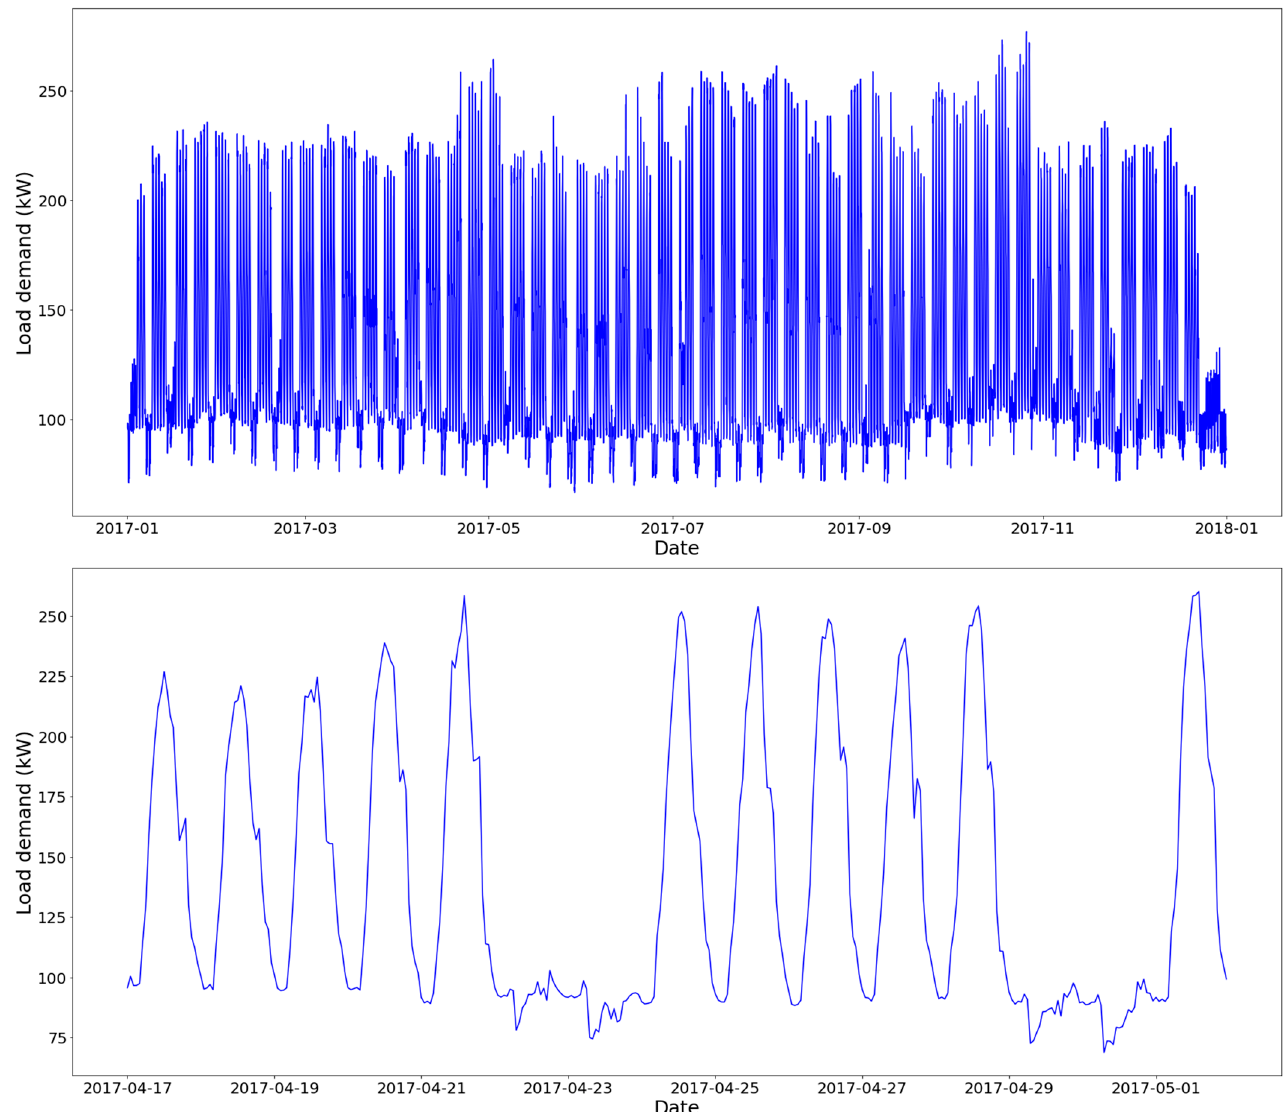
Figure 1. Power demand data for the Student Services Center building for ( top ) the complete year dataset and ( bottom ) two weeks during the academic year.